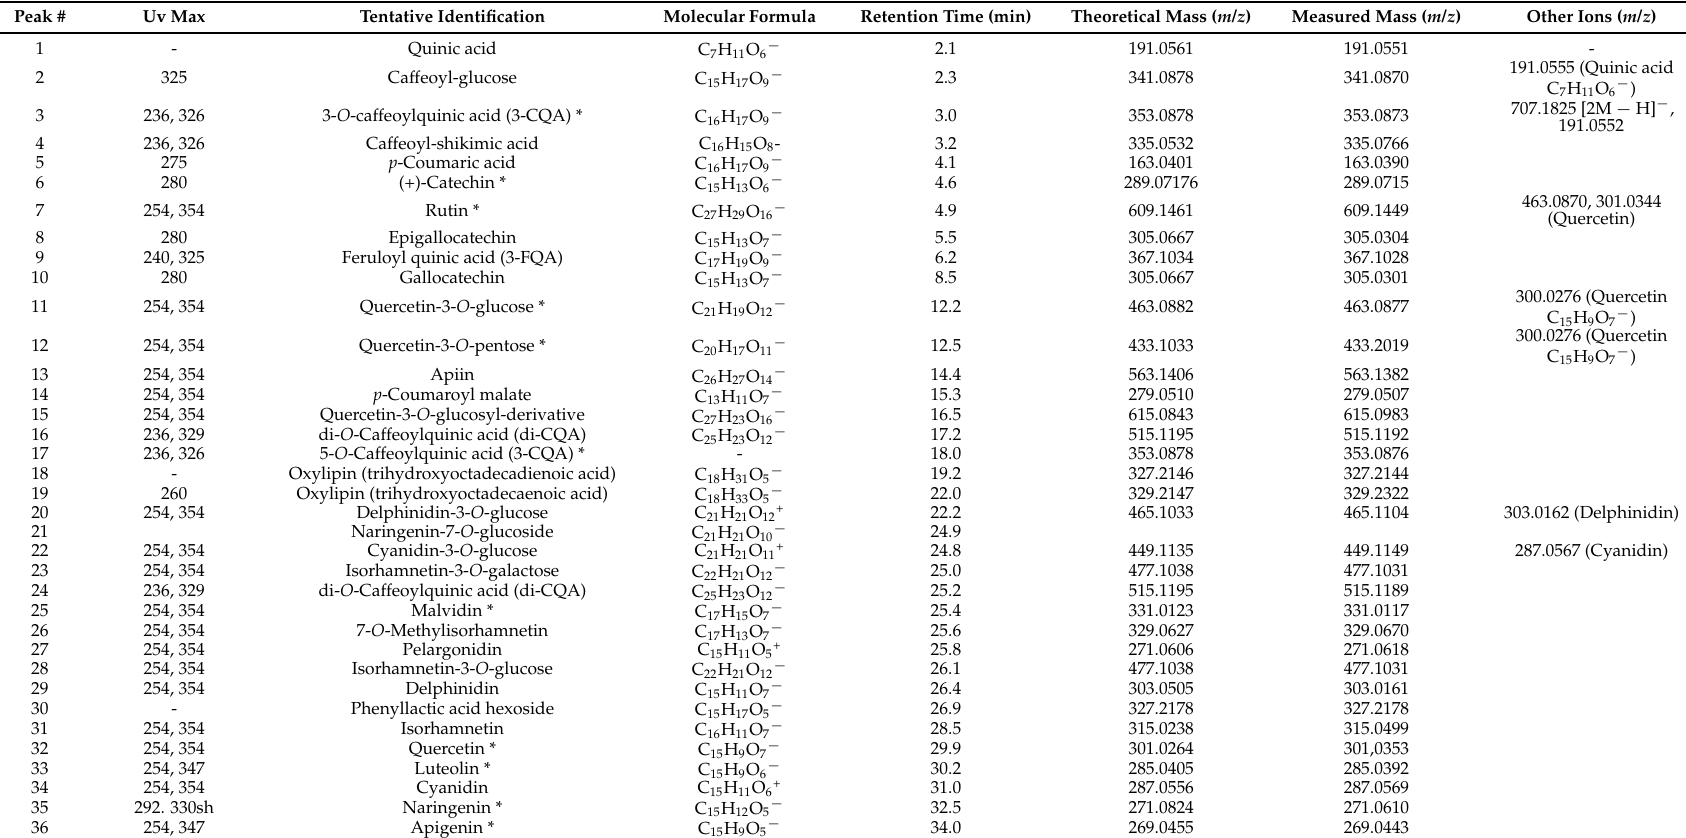
Table 2. Identification of Phenolic Compounds in Tristerix tetrandus leaves and flowers by LC-PDA-HR-OT-ESI-MS